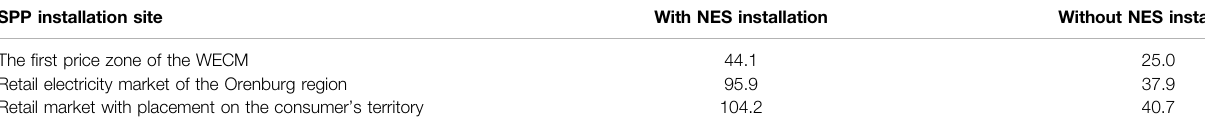
TABLE 2 | Annual income of 10 MW SPP from the sale of electricity and capacity on the energy market, million rubles.